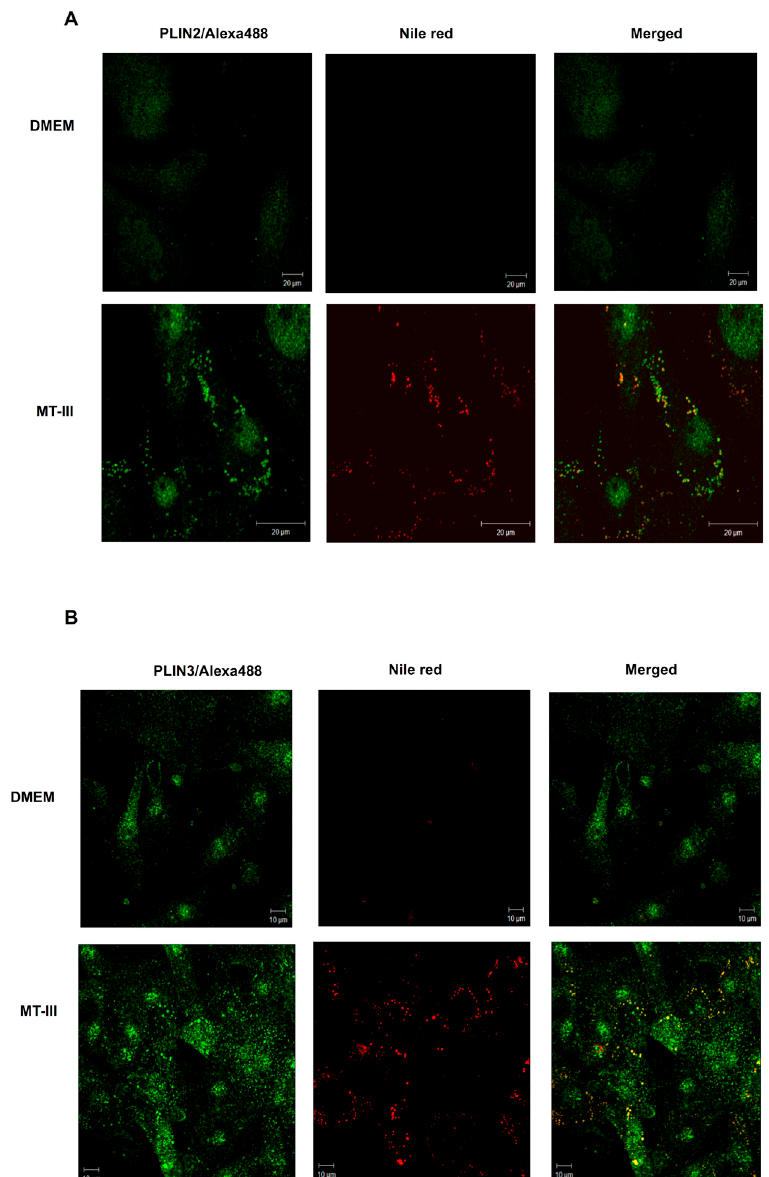
Figure 2. MT-III induces PLIN2 and PLIN3 recruitment to LDs in VSMCs. VSMCs (8 × 10 3 cells/coverslip) were incubated with DMEM (control) or MT-III (0.4 µM) for 12 h and labelled for LDs (with Nile red) and for PLIN2 ( A ) or PLIN3 ( B ) (with fluorescein isothiocyanate- FITC-conjugated secondary antibody). The merged image shows co-localization of PLIN2 and PLIN3 to LDs. The pictures are representative of three independent experiments ( n = 9).